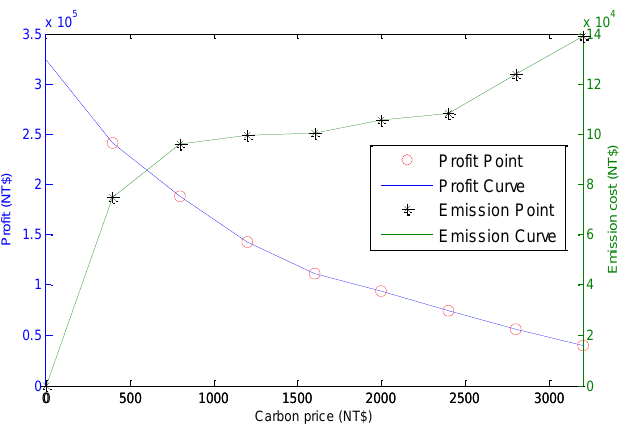
Figure 8. Profit-emission tradeoff curves during the peak period.